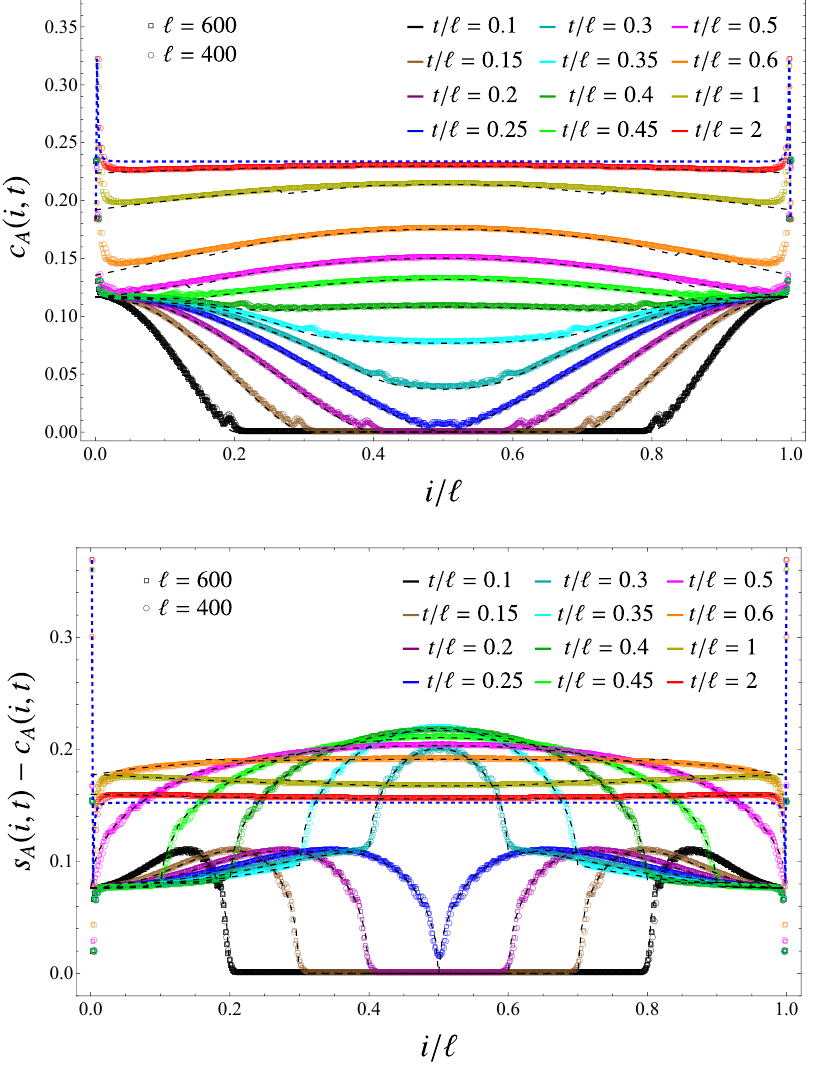
Figure 12 . Temporal evolution of the contour function of the capacity of entanglement c A ( i, t ) (top panel) and of s A ( i, t ) − c A ( i, t ) after the global quench in the free fermionic chain described in section